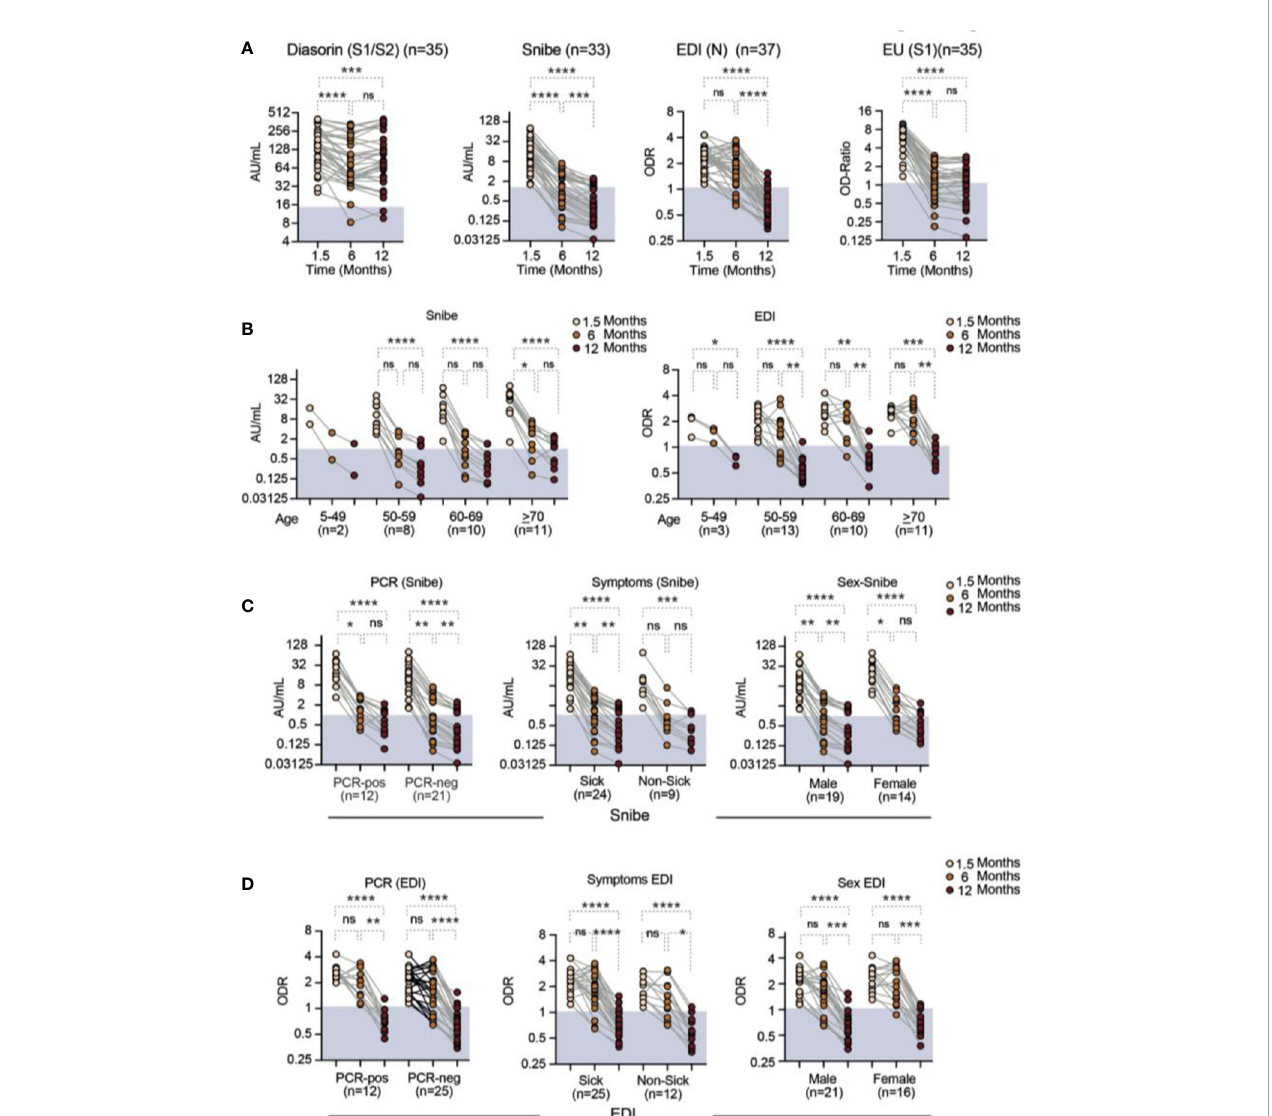
FIGURE 2 Anti – SARS-CoV-2 antibody levels over time as assessed with the three quantitative and one semiquantitative (Euroimmune; EU) antibody tests as indicated (A) all participants. Strati fi ed by (B) age for the Snibe (left panel) and EDI test (right panel). (C) Results from the Diasorin Snibe antibody test strati fi ed for PCR status (left panel), asymptomatic versus symptomatic disease (middle panel) and sex (right panel). (D) Same as (C) for EDI test. N = number of individuals per group. Friedman test with Dunns post-hoc analysis. * p < 0.05; ** p < 0.01; *** p < 0.001; **** p < 0.0001. AU, arbitrary units; ns, non-signi fi cant ( p > 0.05); ED, EDI Novel Coronavirus SARS-CoV-2 IgG ELISA kit (Epitope Diagnostics Inc., San Diego, CA, USA); EU, Euroimmune (anti – SARS-CoV-2-ELISA (IgG); SN, 2019-nCoV IgG kit (Snibe Co., Ltd., Shenzhen,